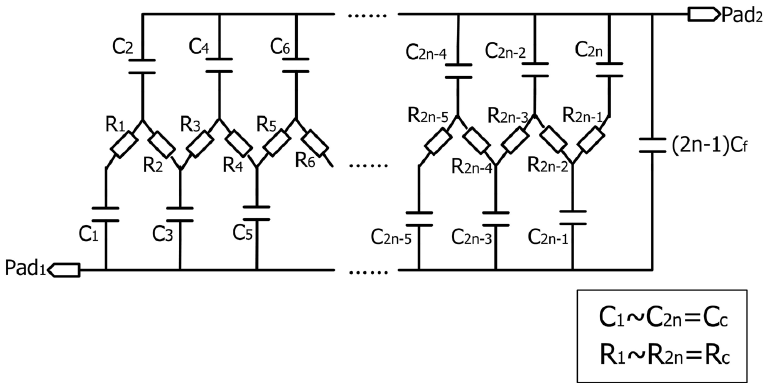
Figure 2. Equivalent circuit of an interdigitated capacitive humidity sensor with a nanowire coupling electrode.